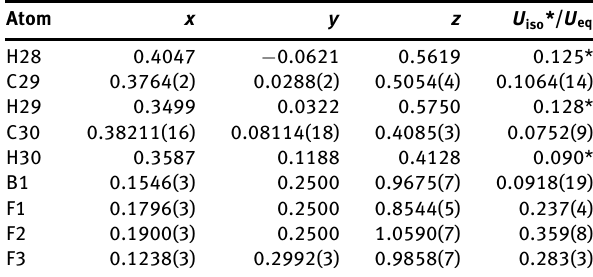
Table 2: Fractional atomic coordinates and isotropic or equivalent isotropic displacement parameters (Å 2 ).